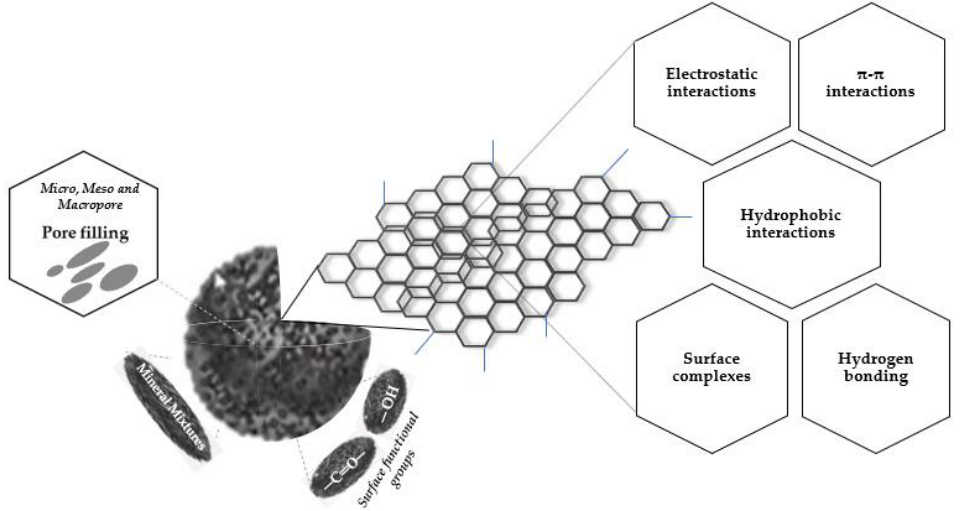
Figure 5. Involving factors of SC adsorption mechanism.